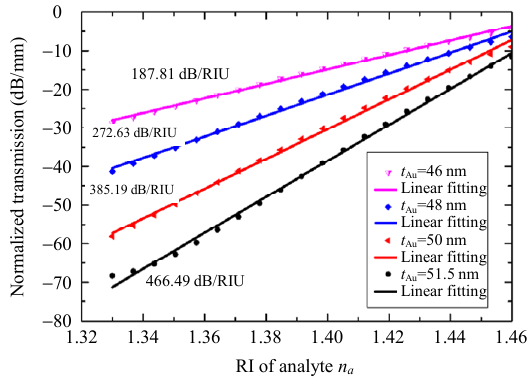
Fig. 6 Dependence of the normalized transmission on RI of the analyte for different gold film